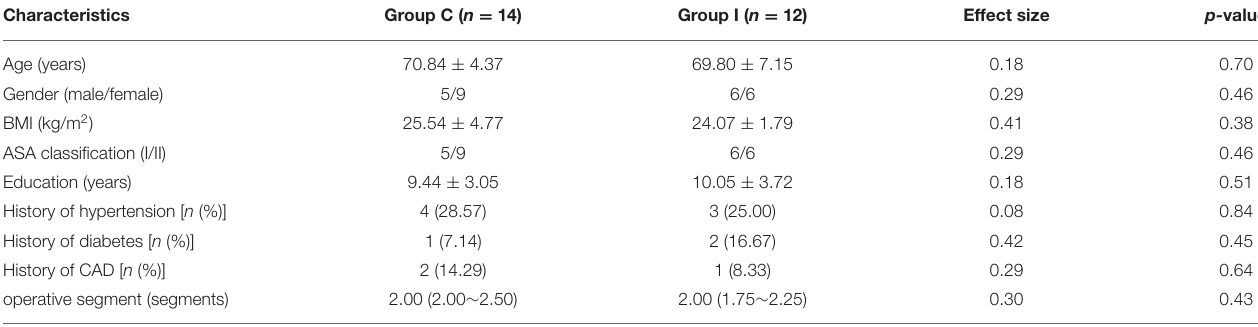
TABLE 1 | The demographic characteristic data of